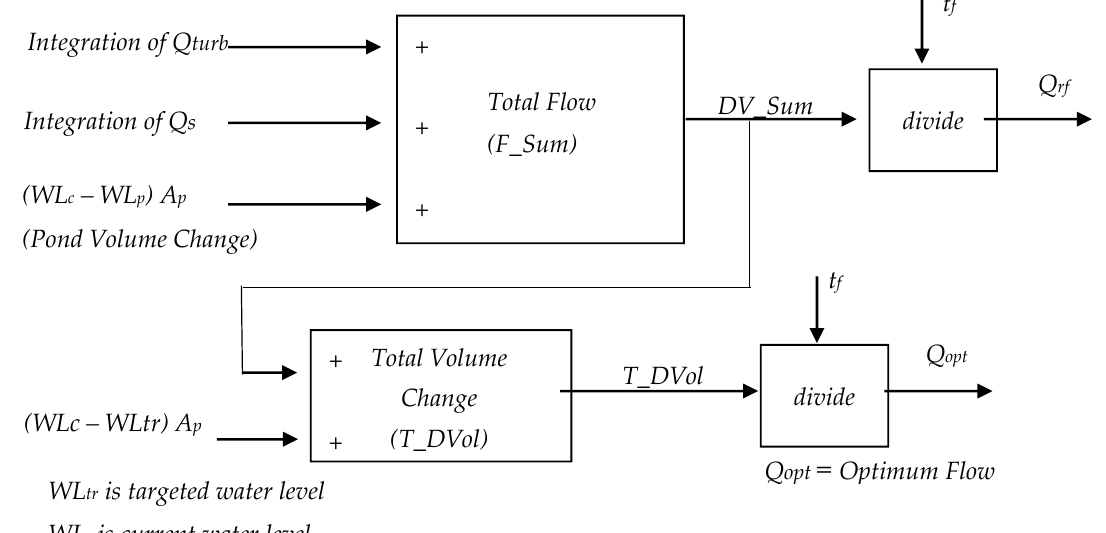
Figure 7. Calculation of turbine discharge flow set point ( Q opt